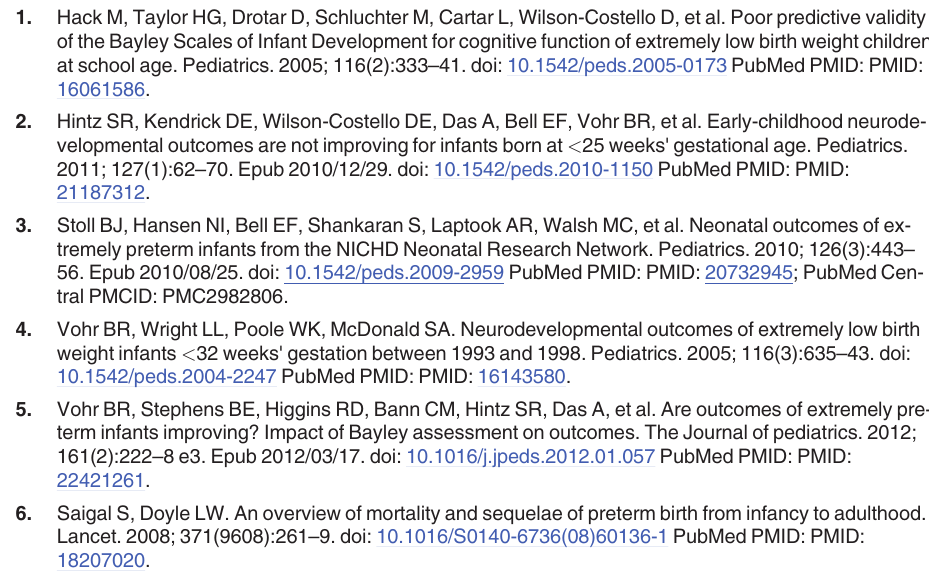
S1 Table. Primers used in qRT-PCR assays with the Biomark